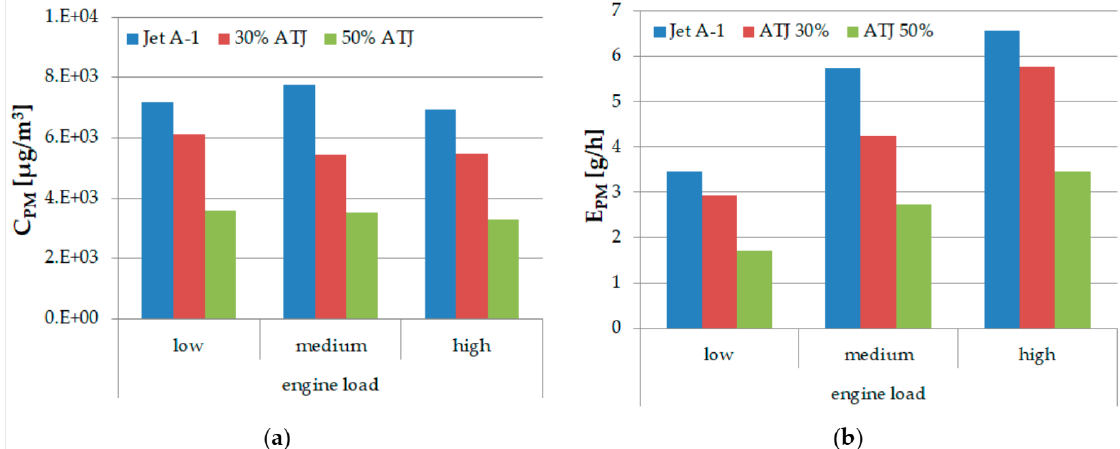
Figure 9. Mass concentration C PM ( a ) and emission intensity of particulate matter E PM ( b ) for tested fuels in three engine operation